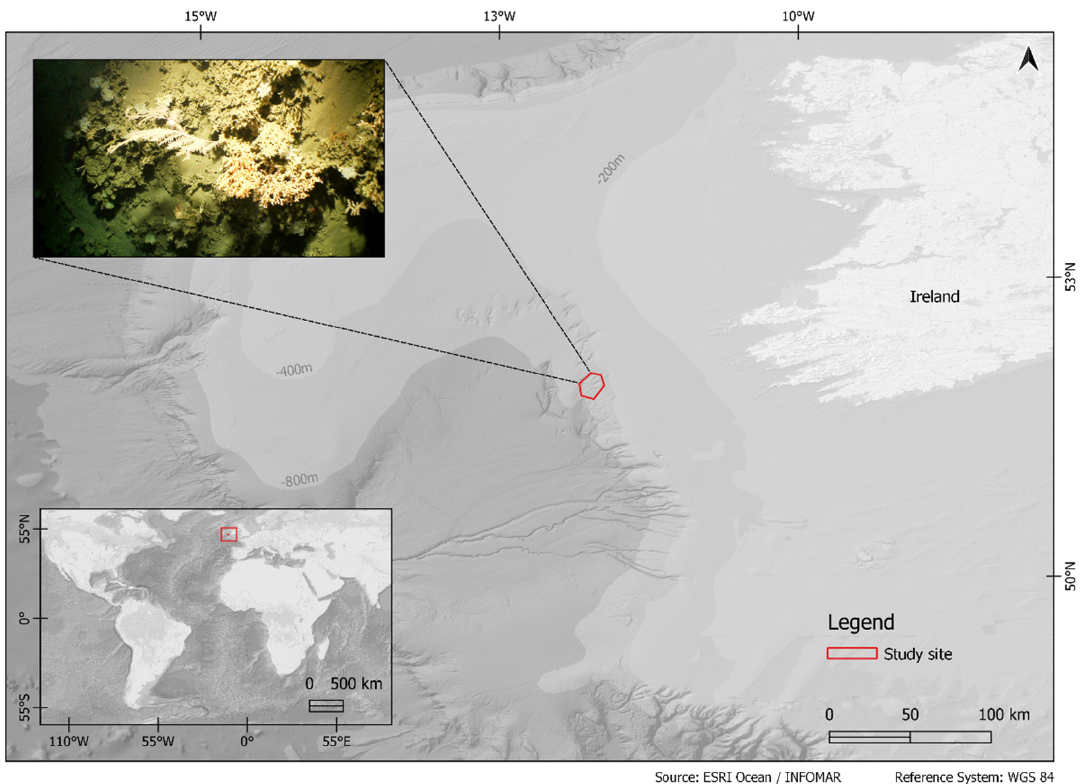
Figure 1. Location of the study site in the Piddington Mound, Belgica Mound Province area relative to the Irish margin. Upper left: extracted HD video frame of the study site.